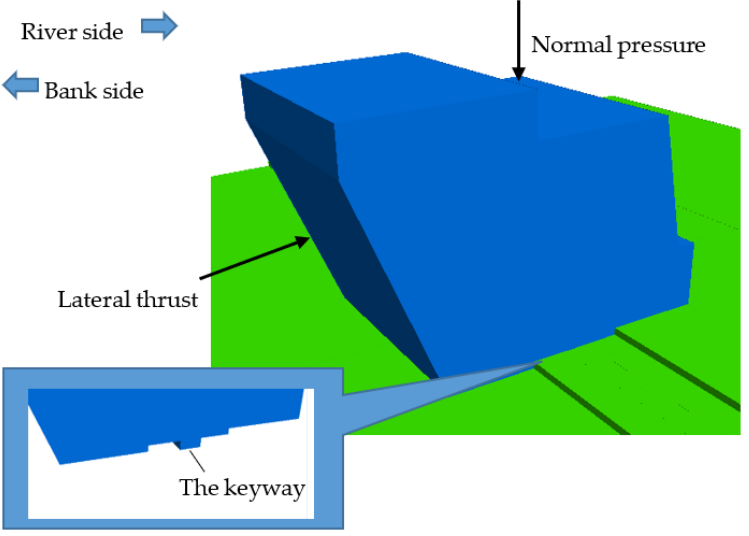
Figure 8. DEM model of the scaled anchorage model.